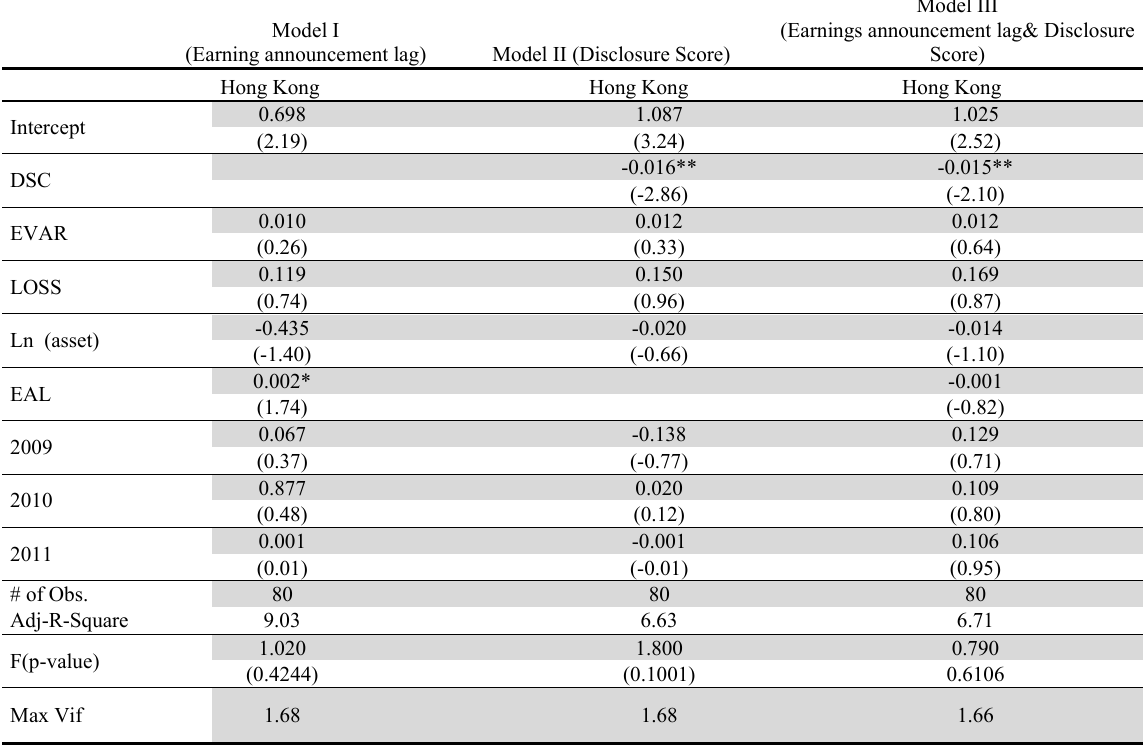
Multiple regression analyses Model I (Earning announcement